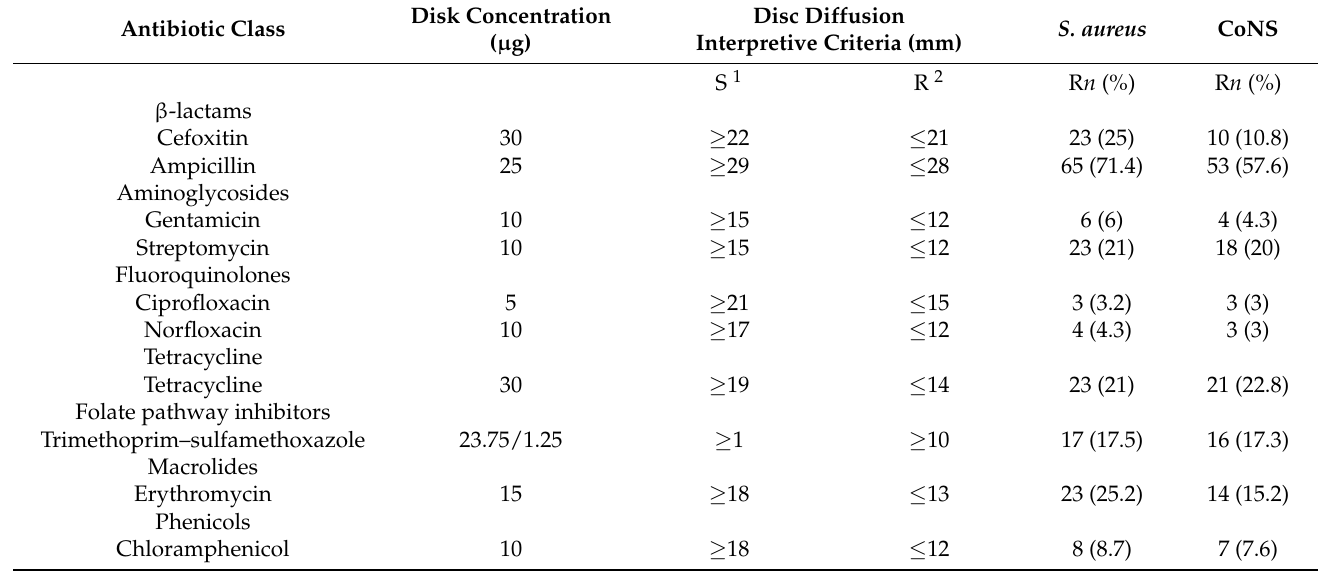
Table 1. Antibiotic susceptibility patterns of 183 staphylococci isolated from mastitic cow milk in two counties, Kenya. Disk Concentration Disc Diffusion Antibiotic Class ( µ g) Interpretive Criteria (mm)